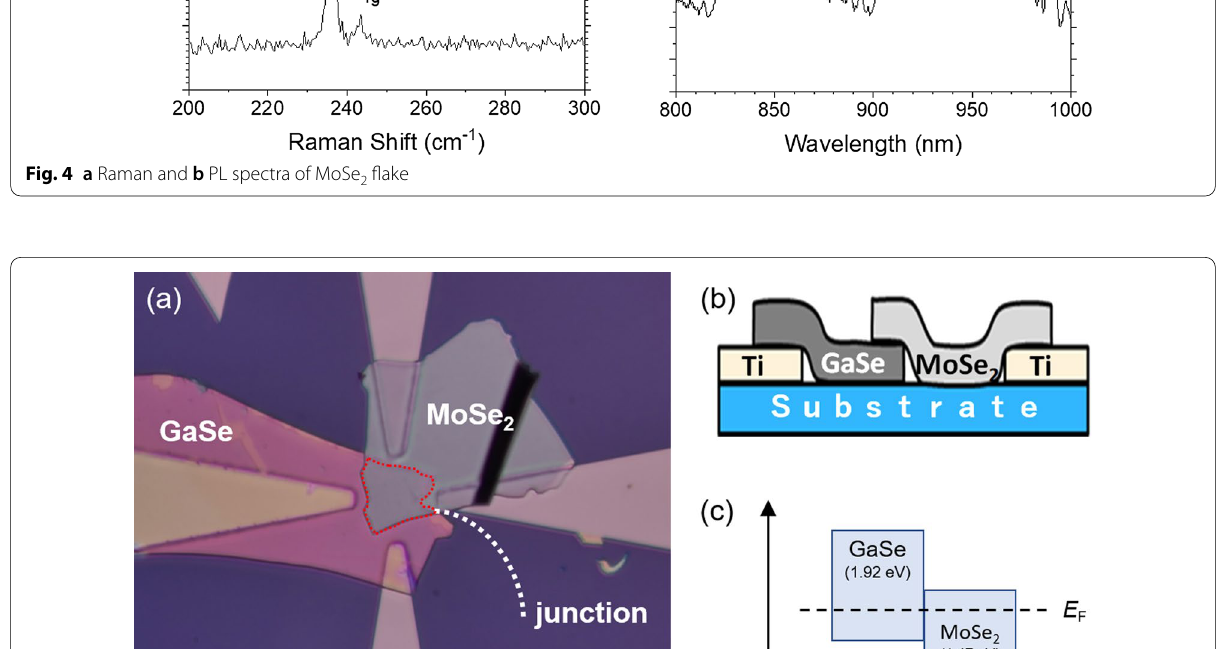
Fig. 5 a Optical microscopic image, b schematic image, and c band diagram of the fabricated GaSe/MoSe 2 heterojunction